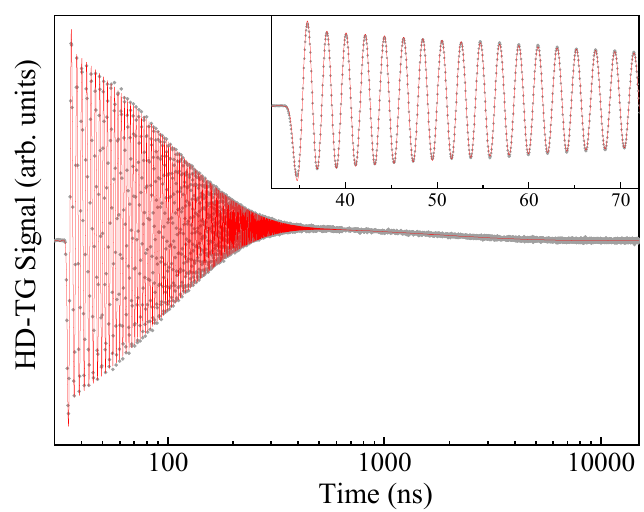
Figure 1. Heterodyne transient grating (HD-TG) decay signal (gray dots) and its relative fit (red line) of 120 mg/mL lysozyme aqueous solution at T = 23 °C and wave-vector q = 2.1 µm − 1 .